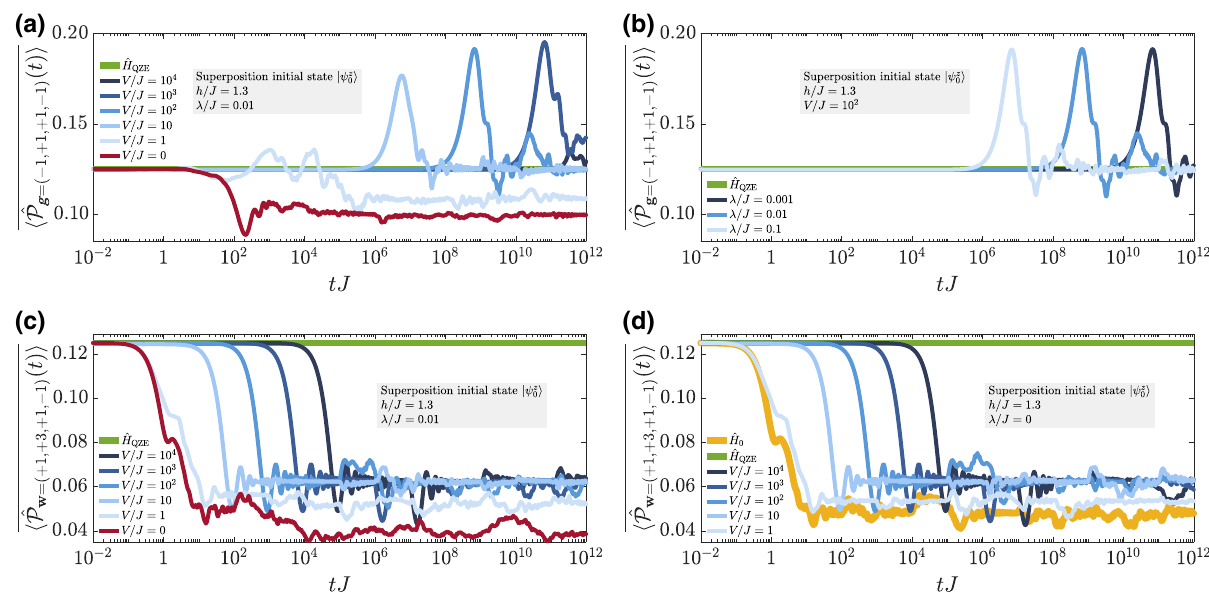
ˆ FIG. 5. Quench dynamics of the projectors onto (a),(b) the superselection sectors g of G j and (c),(d) the superselection sectors w of ˆ P ˆ H = ˆ H ˆ W + λ ˆ H + V ˆ H 0 1 j . (a),(b) The quench dynamics of g under the faulty theory W restores its original value with larger V up to a timescale ∝ V 2 /(λ 2 J ) , which exceeds the analytic prediction from the quantum Zeno effect (see Sec. IV). The timescale up to which (cid:6) ˆ P (cid:3) retains its initial value matches that at which the imbalance leaves its second prethermal plateau and begins to thermalize to zero, g ˆ P λ = 0.01 J and (d) λ = 0 indicate a common timescale ∝ V / J 2 at which (cid:6) ˆ P (cid:3) as shown in Fig. 4(b). The quench dynamics of w at (c) w deviates from its initial value, showing that it depends more strongly on ˆ H 0 than the gauge-breaking term λ ˆ H 1 . These results confirm that up to a timescale ∝ V / J 2 , an emergent gauge theory ˆ H QZE faithfully reproduces the quench dynamics, where this theory hosts an enhanced local symmetry associated with ˆ W j that contains the Z 2 gauge symmetry of ˆ H 0 . After this timescale, the enhanced local symmetry reduces to the original Z 2 gauge symmetry, and a new renormalized Z 2 gauge theory